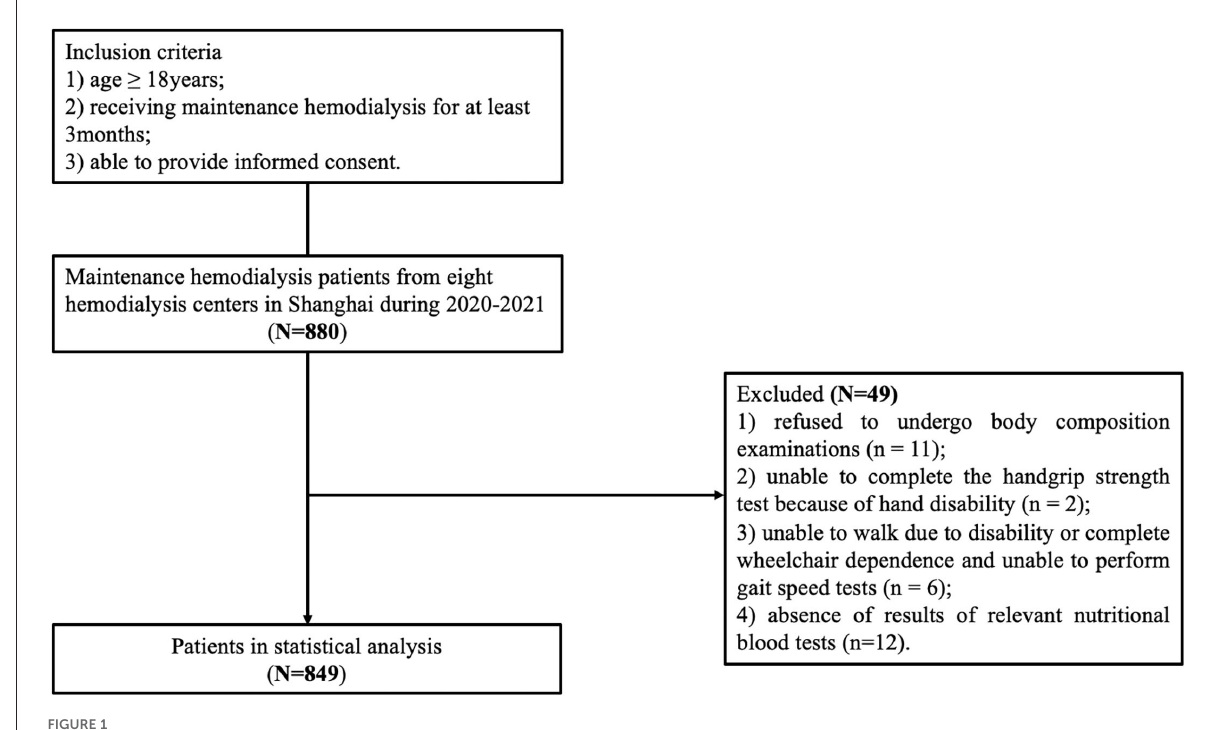
FIGURE1 Flow chart of the study.